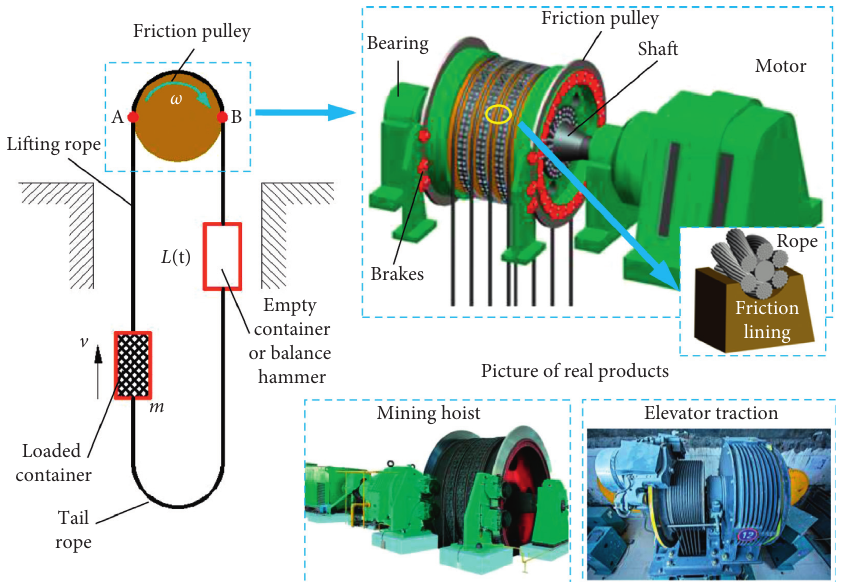
Figure 1: Diagram of the multirope friction hoist